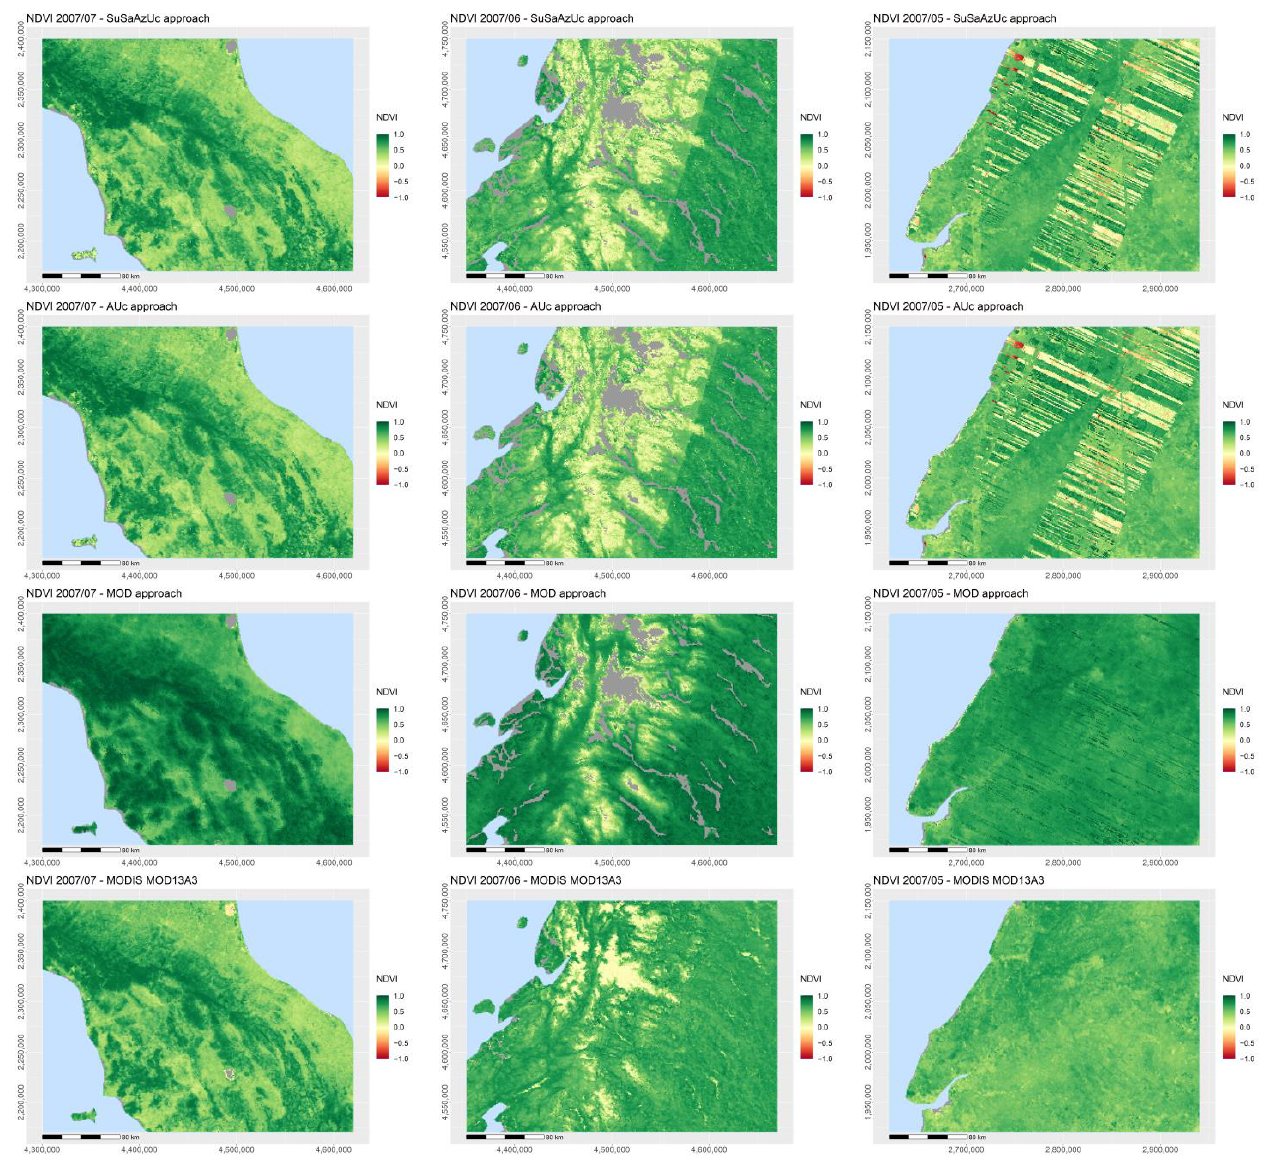
Figure 7. Zoom to focus A ( left column ), B ( middle column ), and C ( right column ) of the monthly NDVI maps based on the different compositing approaches. For focus area locations, see Figure 1.